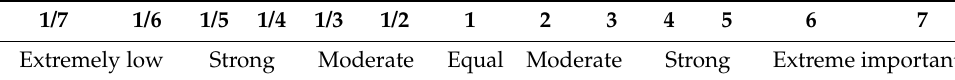
Table 2. Relative importance of two indicators.